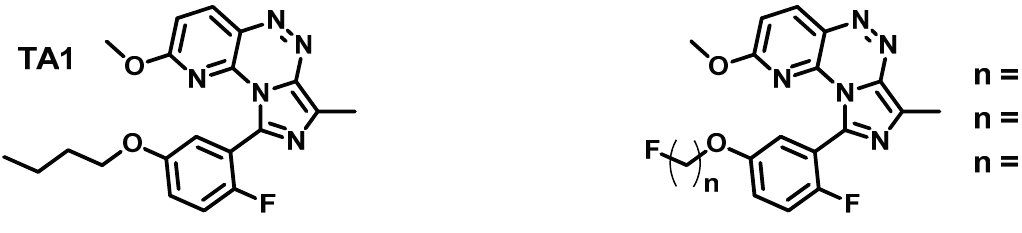
Figure 3. Triazine lead compound TA1 and the novel fluoroalkylated derivatives TA2 – 4 as PDE2A